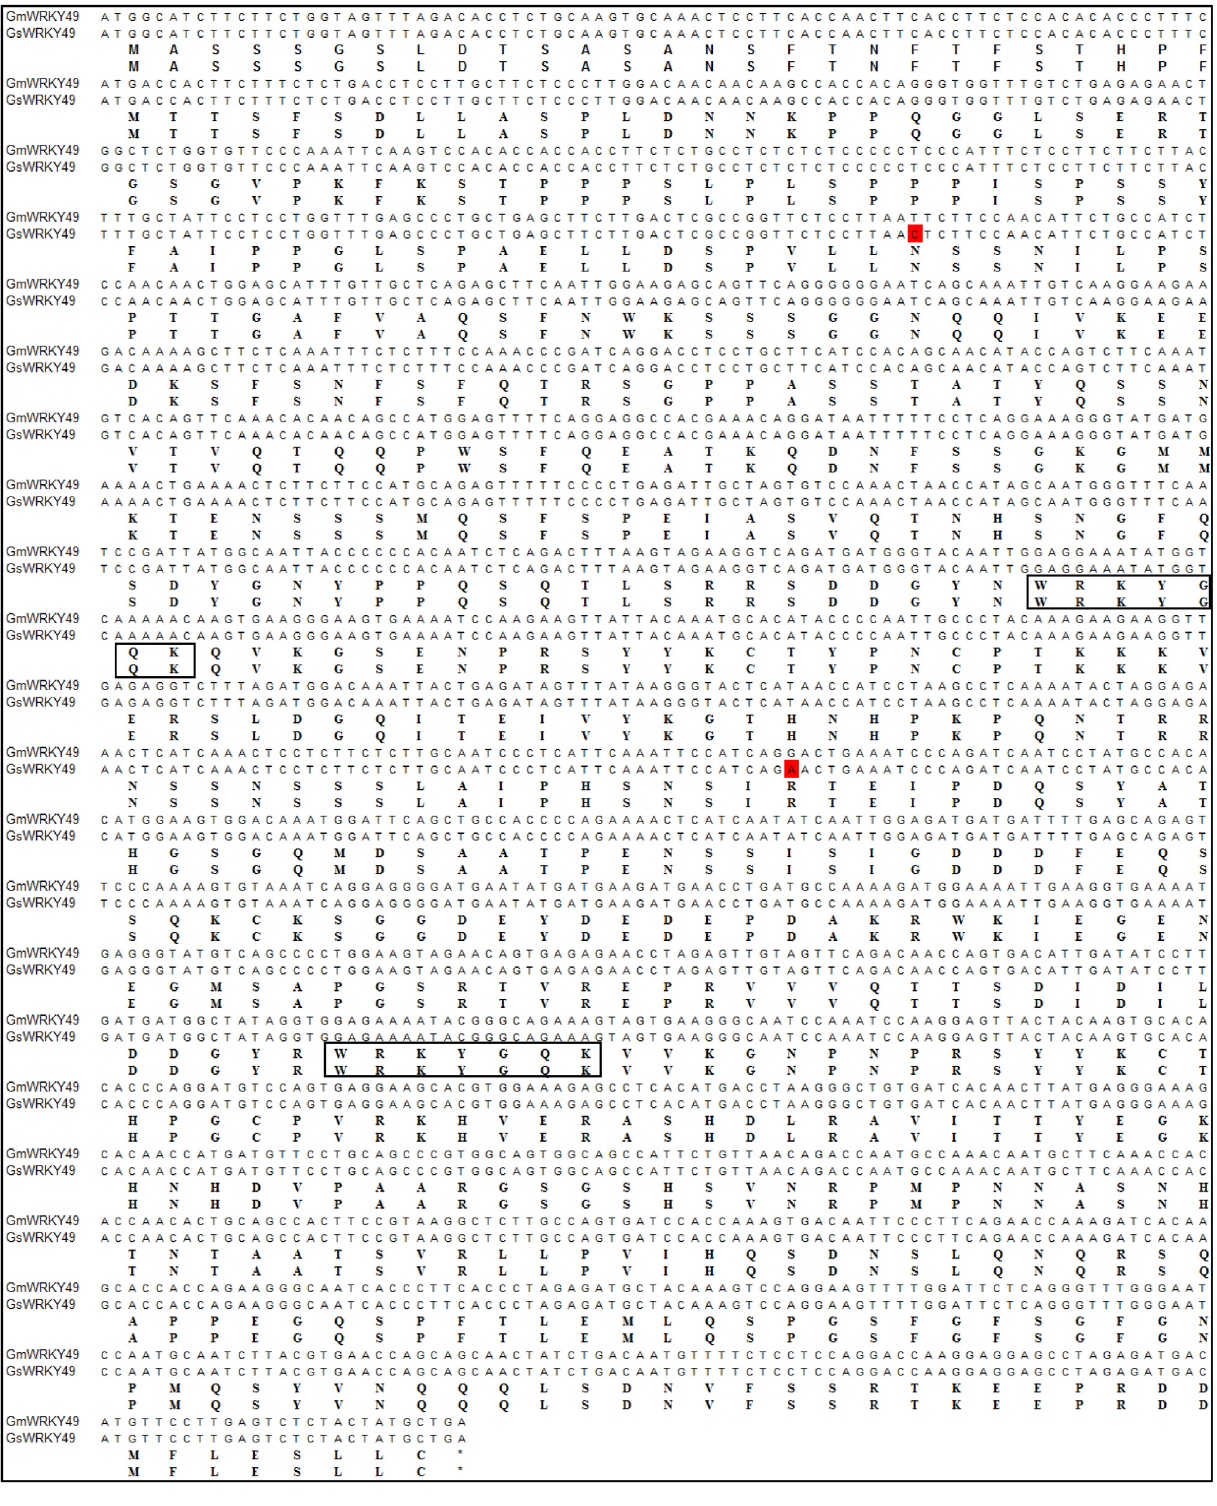
FIGURE 2 | Sequence similarity between cultivated and wild species-specific GmWRKY49. Full-length nucleotide and amino acid sequence alignments of Glycine max (GmWRKY49) and Glycine soja (GsWRKY49) specific genes. Substitutions are highlighted with red boxes. Rectangles encircle WRKY domains and the asterisk symbol indicates termination